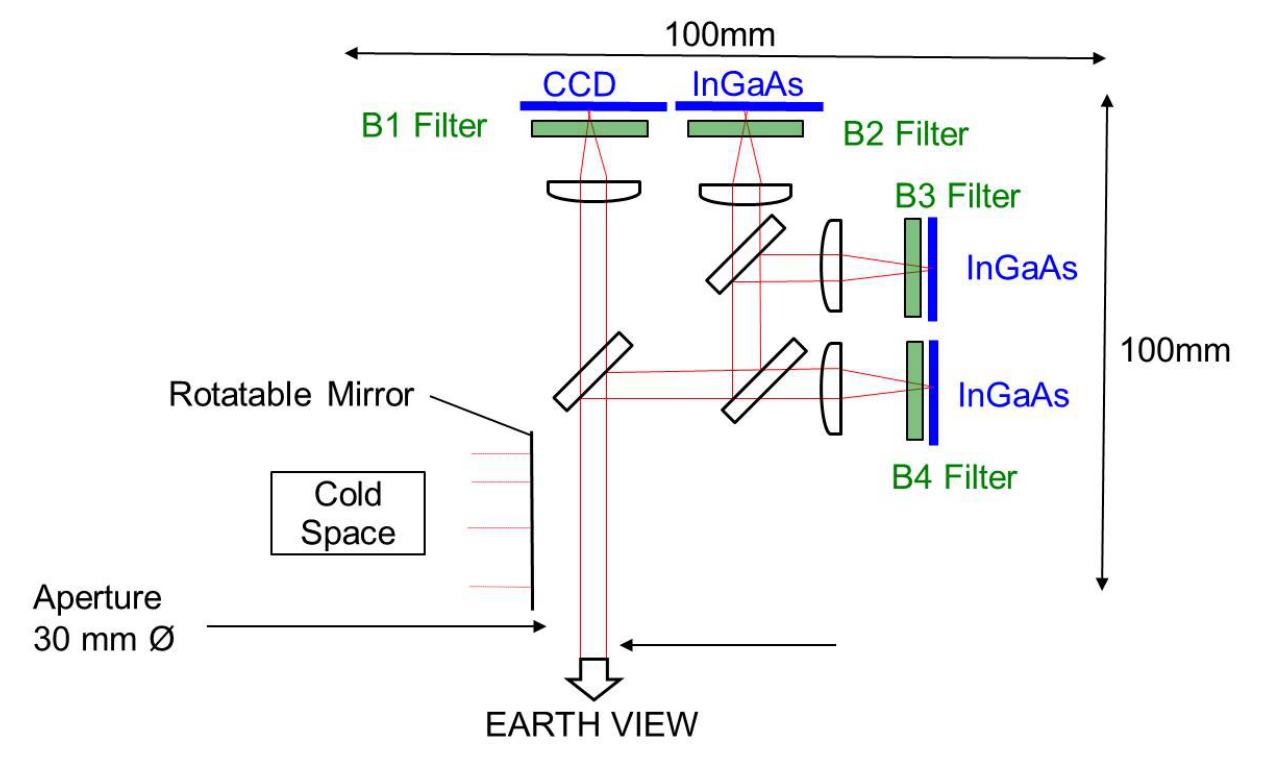
Figure 9. VIS/SWIR system optical